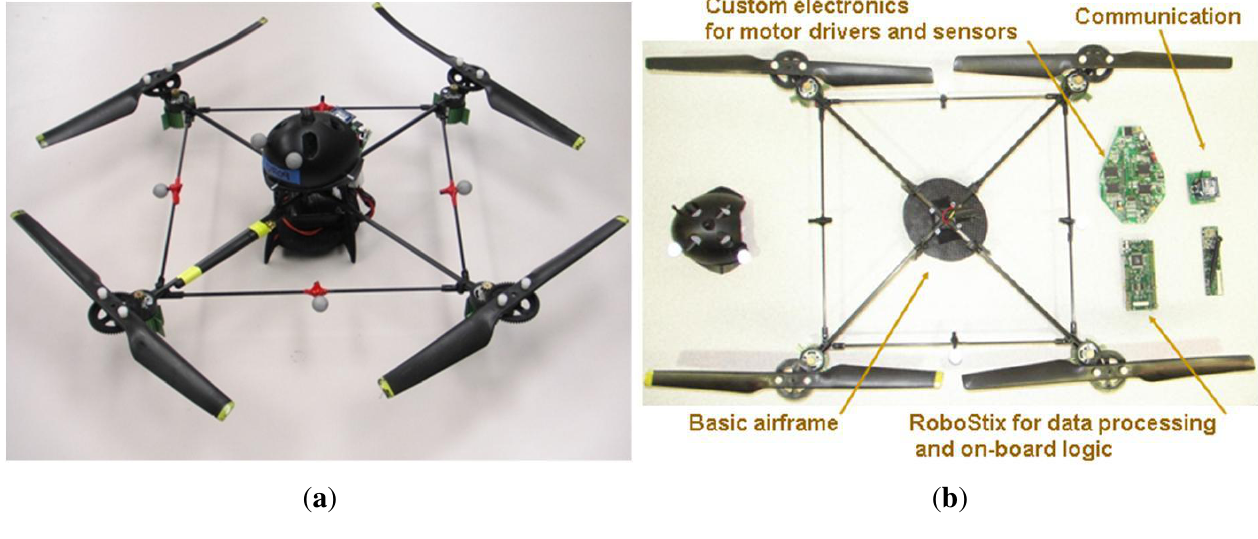
Figure 26. The quad-rotor vehicle ( a ) and its components ( b ). ( a ) Quad-rotor vehicle; ( b ) Vehicle